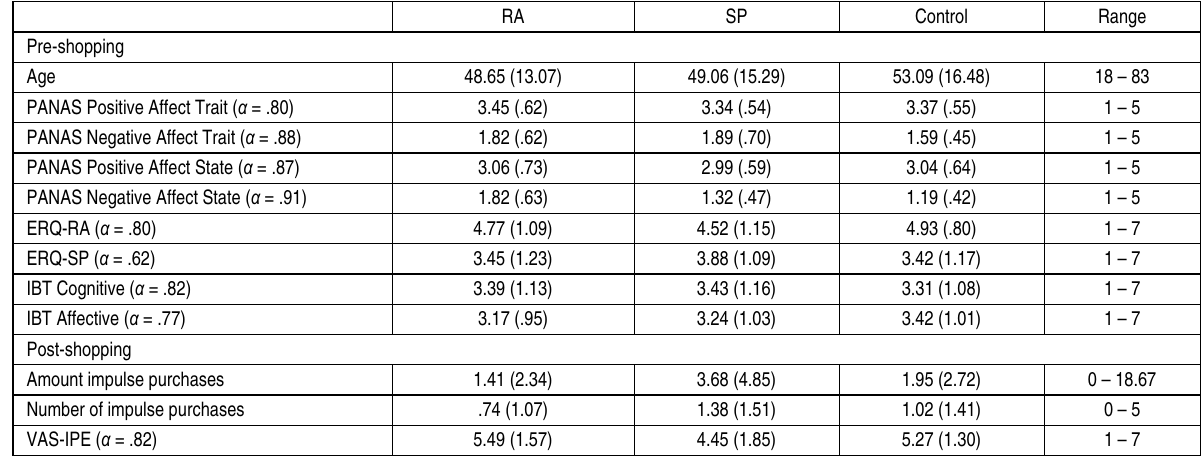
Table 1. Means and standard deviations for all measures RA